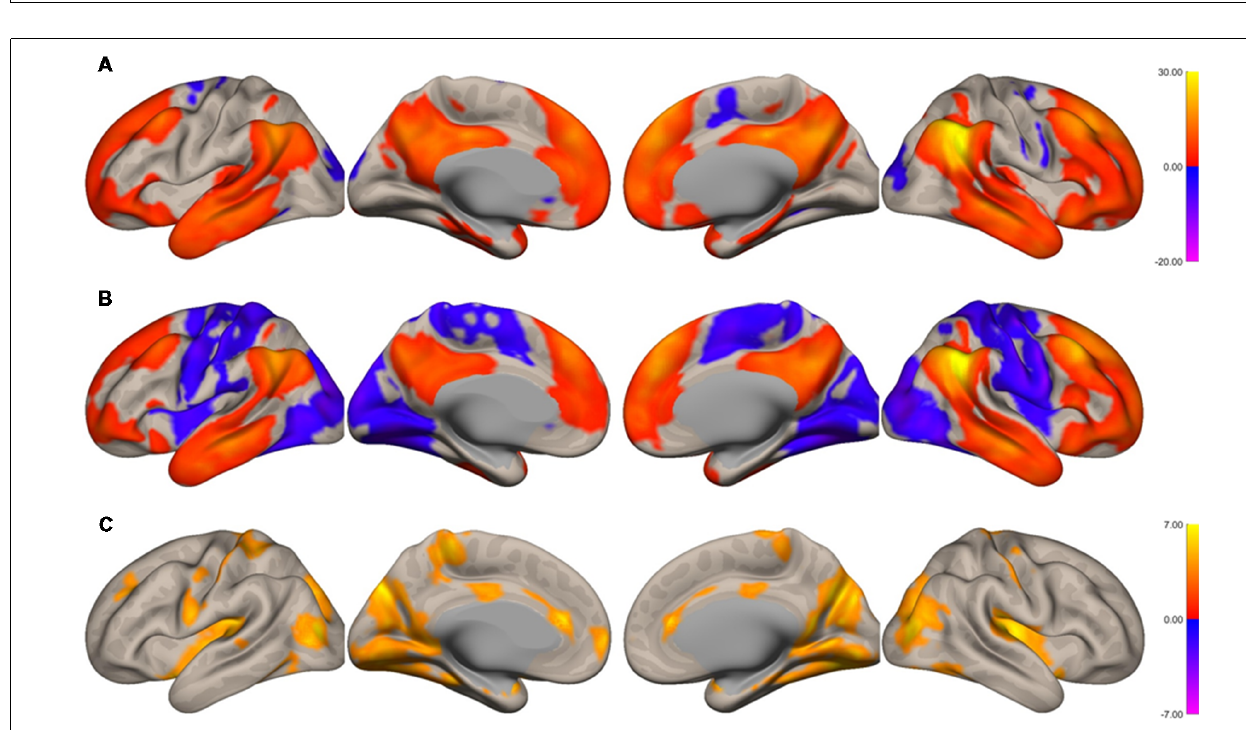
FIGURE 2 | Surface maps of functional connectivity of the right angular gyrus (AG) as the seed region. (A) Imagined music performance. (B) Resting state. (C) Voxels with significant differences in connectivity with the right AG in imagined music performance vs. the resting condition. The significance level was peak-voxel p < 0.001, uncorrected, and cluster p < 0.05, family-wise error corrected.